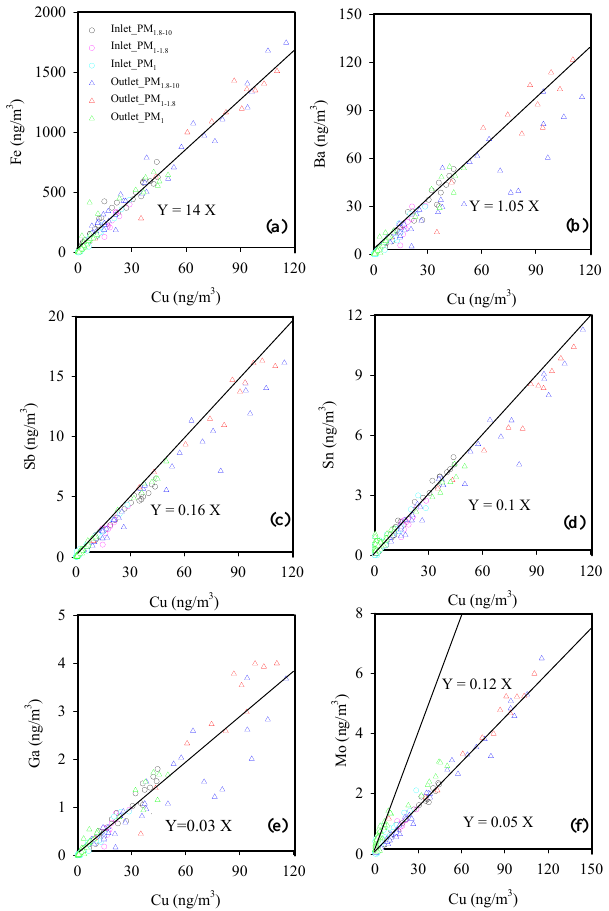
Figure 4. Scatterplots of (a) Fe, (b) Ba, (c) Sb, (d) Sn, (e) Ga, and (f) Mo against Cu concentrations (ngm − 3 ) in different size- segregated particles observed in Hsuehshan